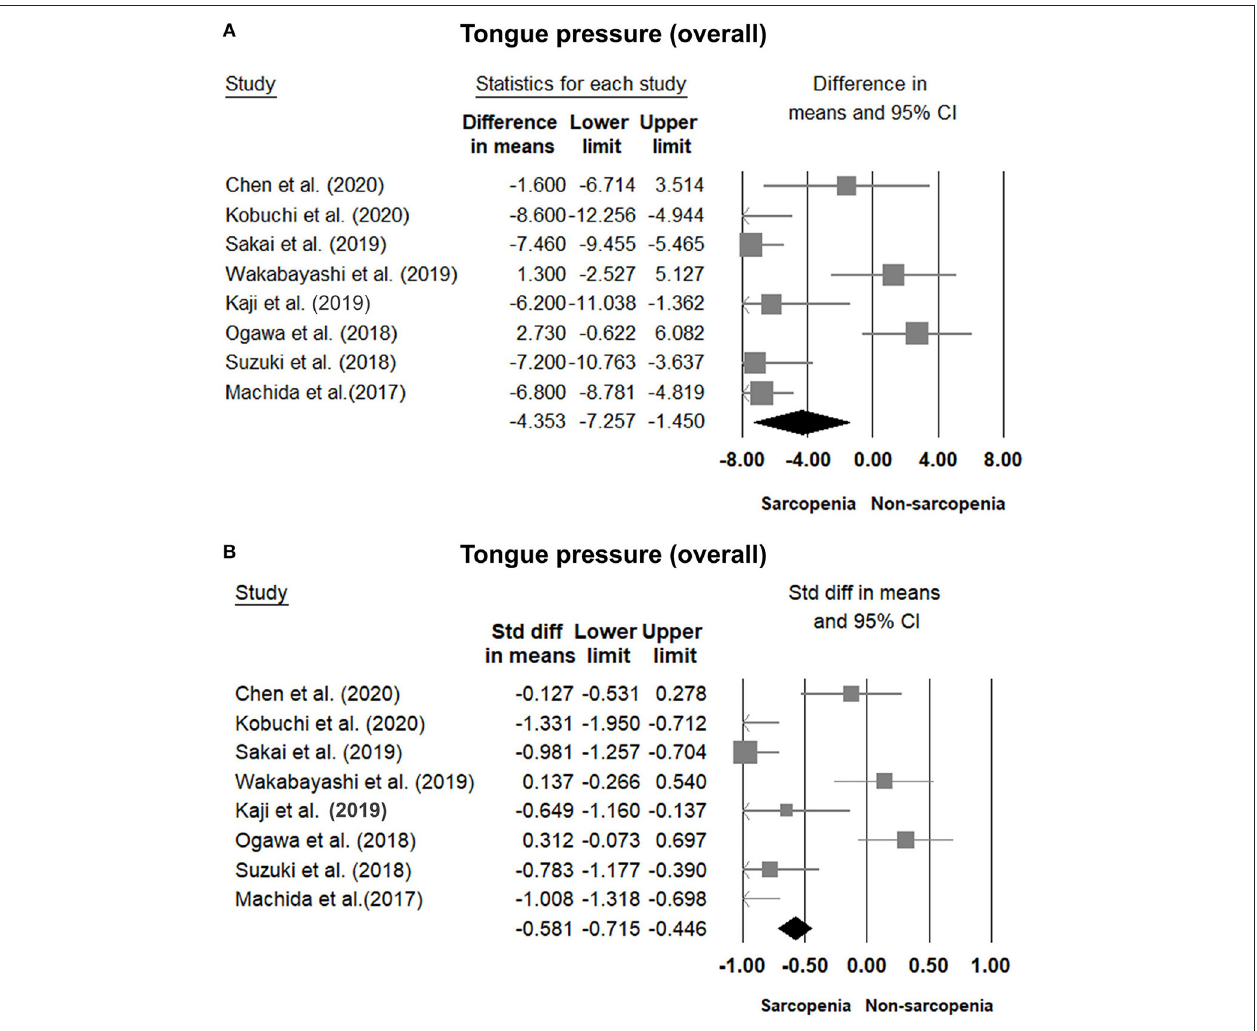
FIGURE 2 | Forest plot of the tongue pressure in the overall participants quantified by the weighted mean difference (A) and standardized mean differences (B) .